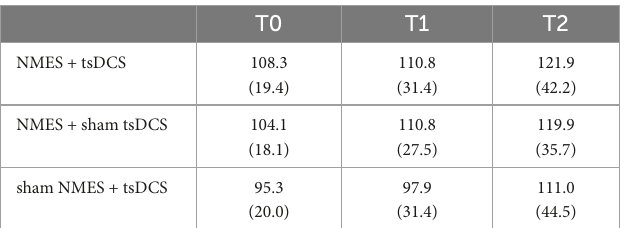
TABLE 3 Changes in %SEPs before and after combined stimulation using neuromuscular electrical stimulation (NMES) and transcutaneous spinal direct current stimulation